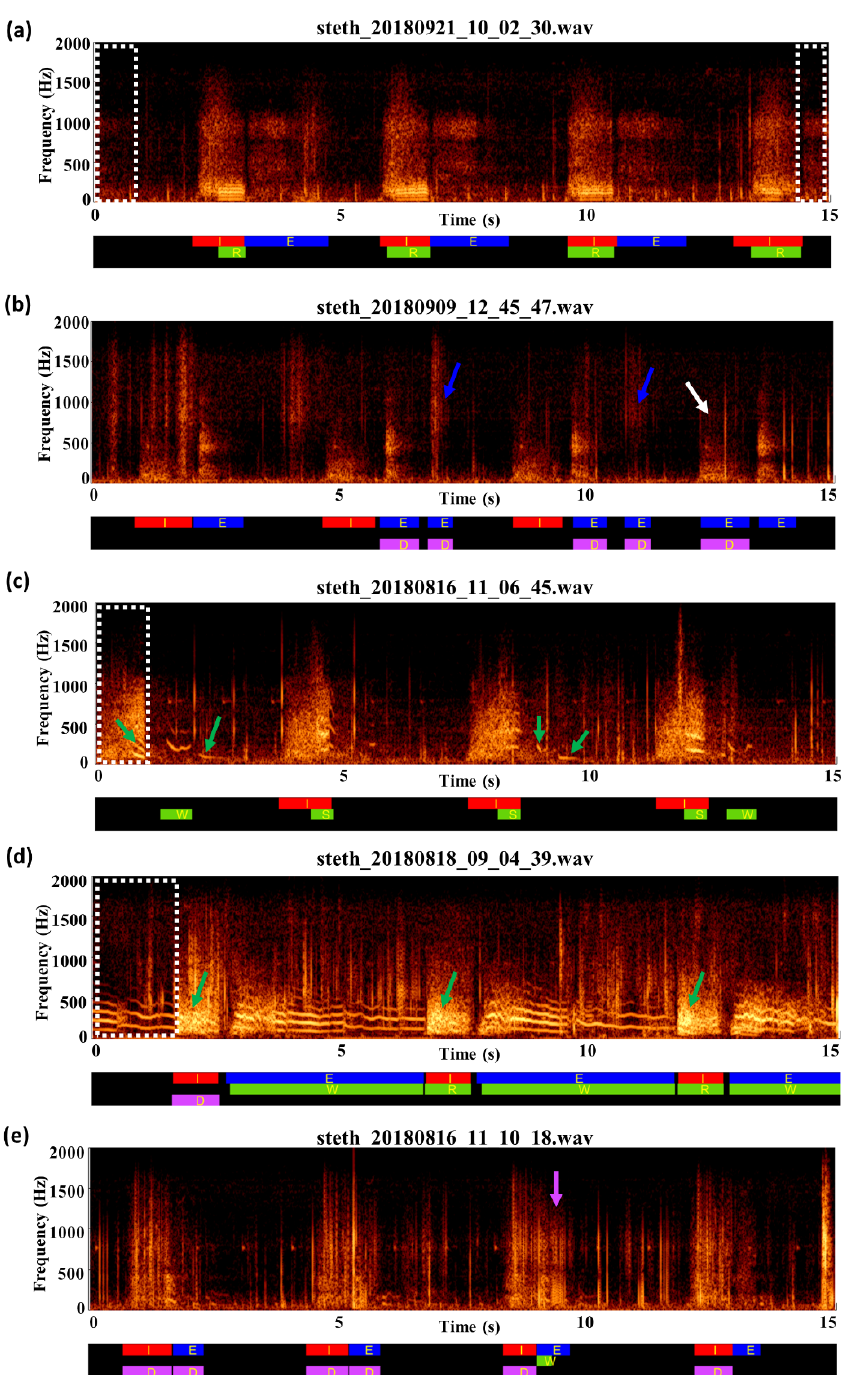
Figure 7. Spectrograms (top) and labels (bottom) of five lung sound recordings. In the label graphs at the bottom, red squares with the letter “I” represent I labels. By the same logic, blue squares with the letter “E” represent E labels, purple squares with the letter “D” represent D labels, and green squares with the letters “S,” “W,” and “R” represent S, W, and R labels, respectively. The blue arrows in ( b ) indicate two sounds with debatable E labels. The white arrow in ( b ) indicates that an inhalation was incorrectly labeled as E. The green arrows in ( c ) indicate CASs that were left without a correct S, W, or R label. The green arrows in ( d ) indicate the sound recordings that did not form clear streak patterns. The purple arrow in ( e ) indicates some noises that interfered with DAS labeling. The white dashed squares in ( a , c , d ) indicate sound events that were left without a label at the beginning and end of a lung sound